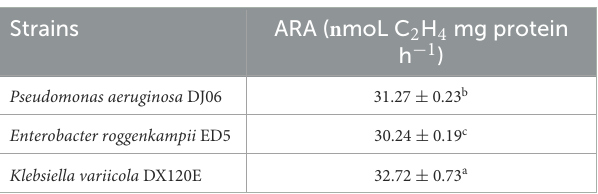
TABLE 3 The nitrogenase activity in the DJ06 strain in comparison with the other two